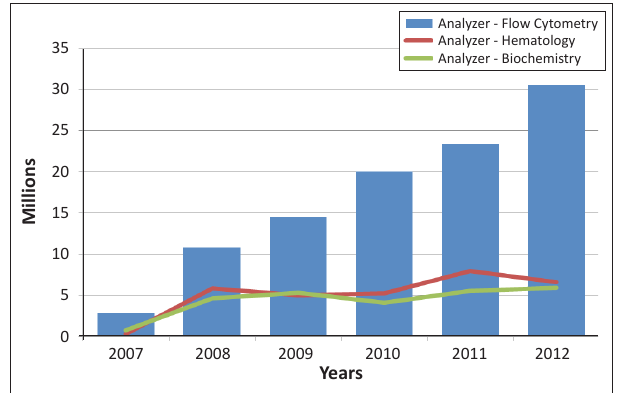
FIGURE 2: Partnership for Supply Chain Management (PFSCM) spending on laboratory commodities delivered through June 2012. PFSCM historical procurement data are displayed as expenditures per year from 2007 through June 2012. PEPFAR flow-cytometry expenditures show continual increases on a per-year basis.